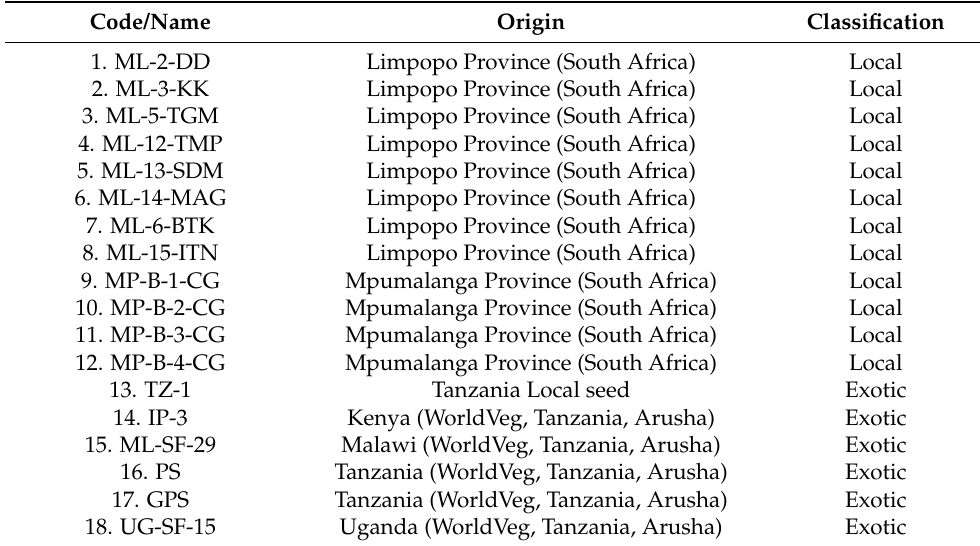
Table 1. Origins of the spider plant accessions that were used in this study.